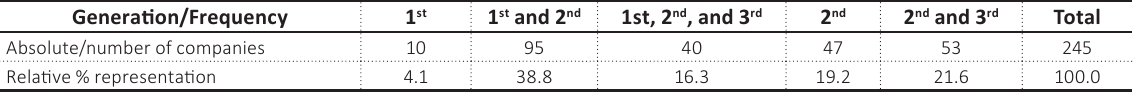
Table 4. Representation of the number of generations